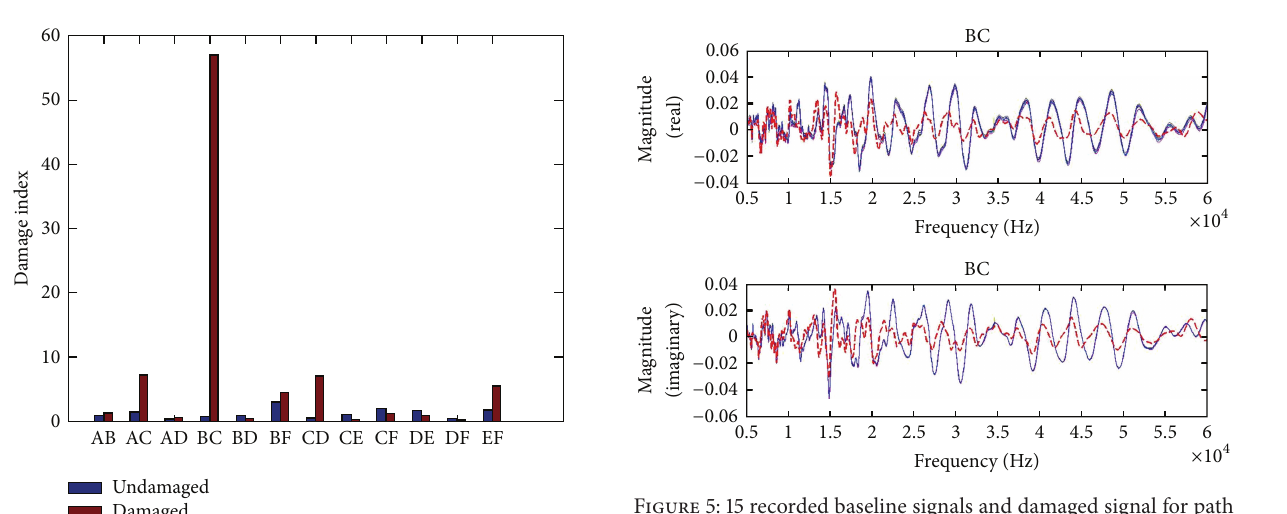
Figure 5: 15 recorded baseline signals and damaged signal for path